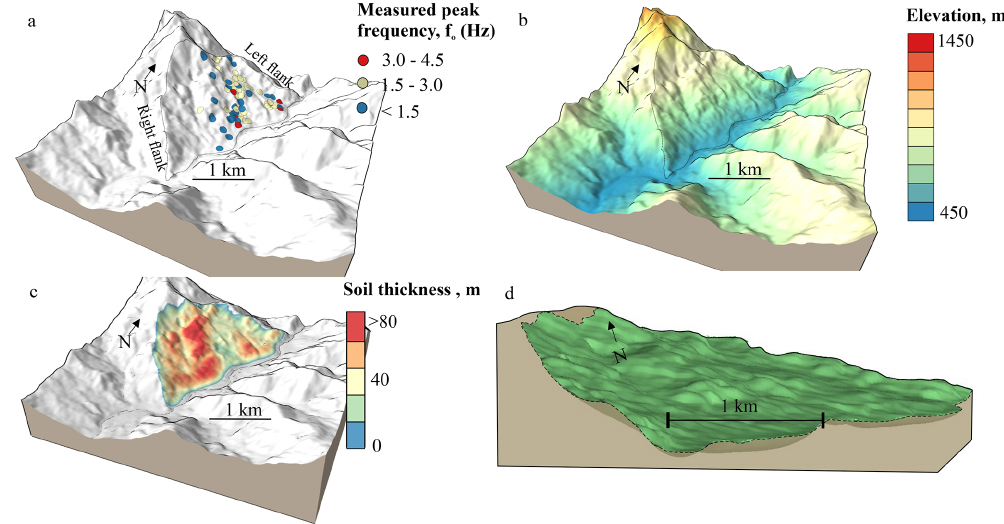
Figure 5. Landslide model construction. (a) Measured peak frequency distribution. Based on Cauchie et al. (2019). (b) Digital elevation model. (c) Soil (or debris) thickness pattern in the landslide. (d) Cross-sectional view of landslide